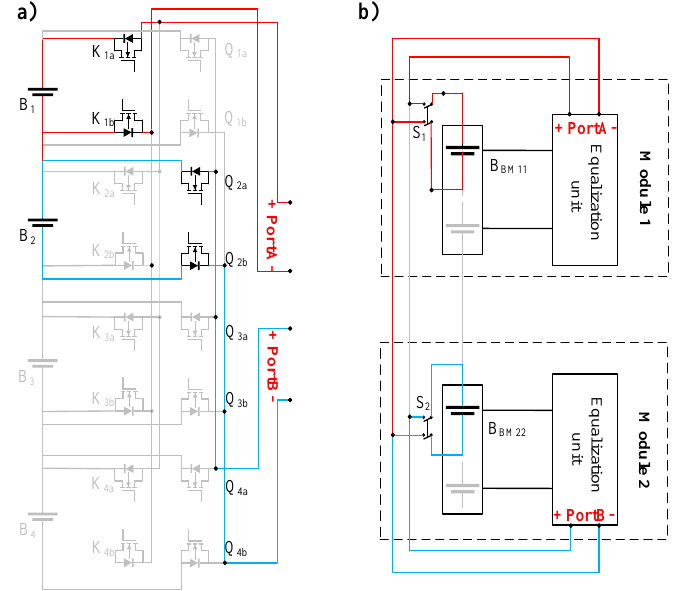
Figure 3. Energy transfer in a balanced topology: ( a ) Intramodule; ( b ) Intermodule.